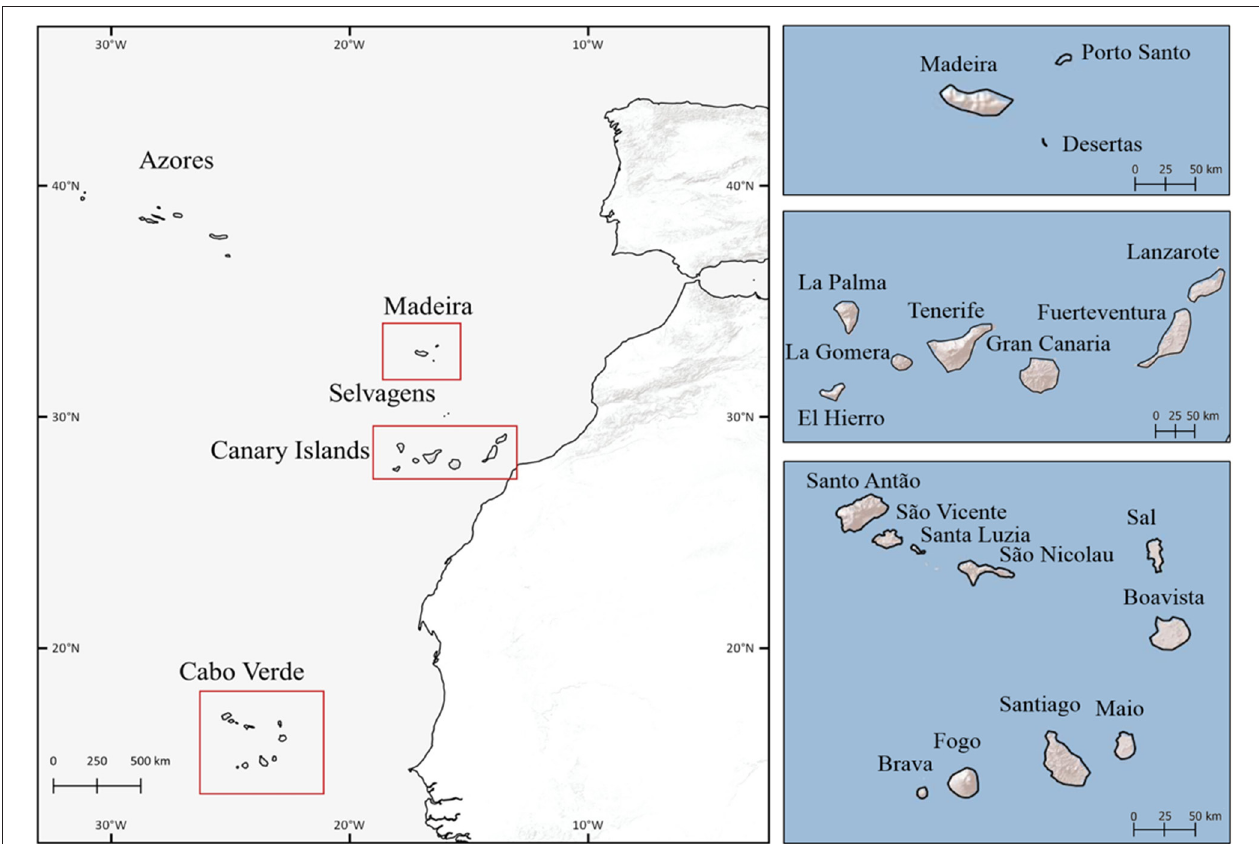
FIGURE 2 | The five archipelagos of Macaronesia Region. The archipelagos included in study area are marked with a red line and represented in further detail in the right side.